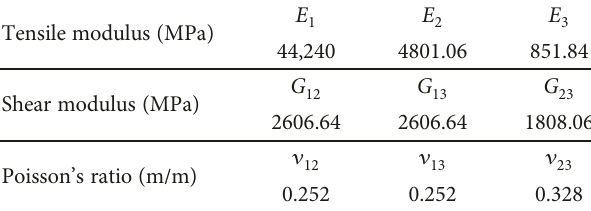
Table 3: Material properties of glass